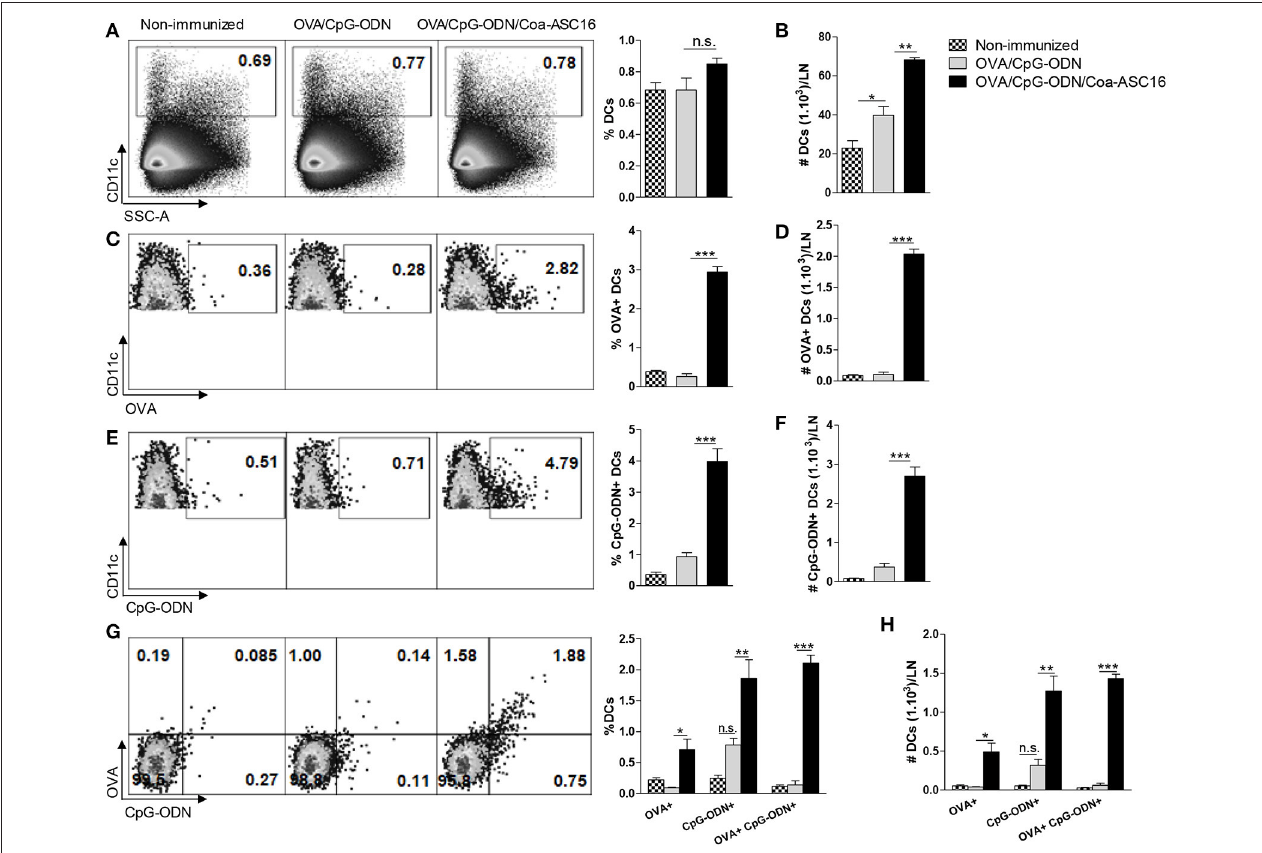
FIGURE 6 | The formulation of OVA/CpG-ODN with Coa-ASC16 enhances in vivo co-uptake of OVA and CpG-ODN by DCs. C57BL/6 mice were immunized in both hind limbs with Alexa Fluor 647-OVA/Alexa Fluor 488-CpG-ODN or Alexa Fluor 647-OVA/Alexa Fluor 488-CpG-ODN/Coa-ASC16. Seventy-two h later, cell suspension from inguinal LN were analyzed by flow cytometry. (A) Percentage and (B) absolute number of total CD11c + DCs. (C) Percentage and (D) absolute number of total OVA + CD11c + DCs. (E) Percentage and (F) absolute number of total CpG-ODN + CD11c + DCs. (G) Percentage and (H) absolute number of OVA + or CpG-ODN + simple positive and OVA + CpG-ODN + double positive within CD11c + DCs. The data show the mean ± SEM of individual values (3-4 mice/treatment group in each experiment) and are representative of two independent experiments performed. n.s., not significant, * p < 0.05, ** p < 0.01, *** p <